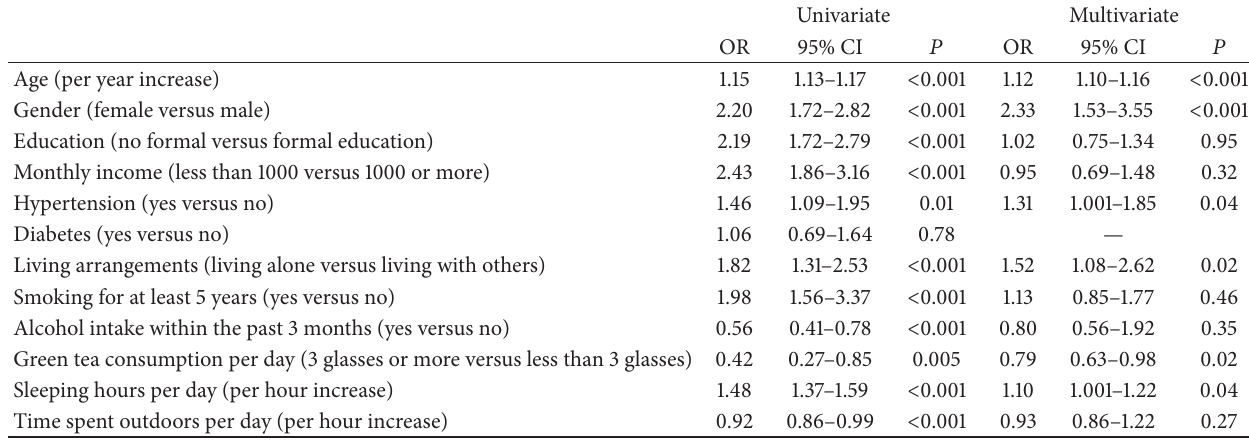
Table 3: Univariate and multivariate of the associated factors for visual